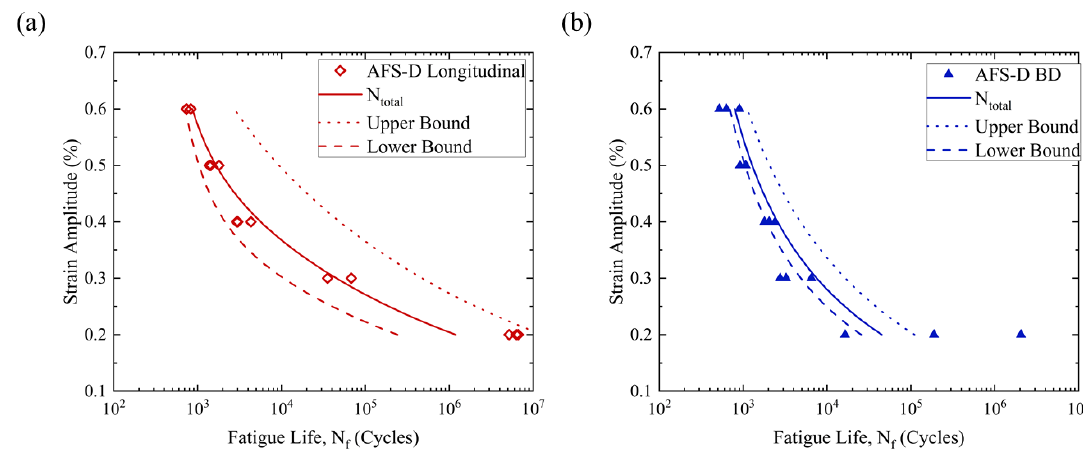
Figure 10. Bound life MSF model plots for ( a ) AFS-D AA6061 in the longitudinal direction and ( b ) AFS-D AA6061 in the build direction. Table 3. MSF parameters for each data set.